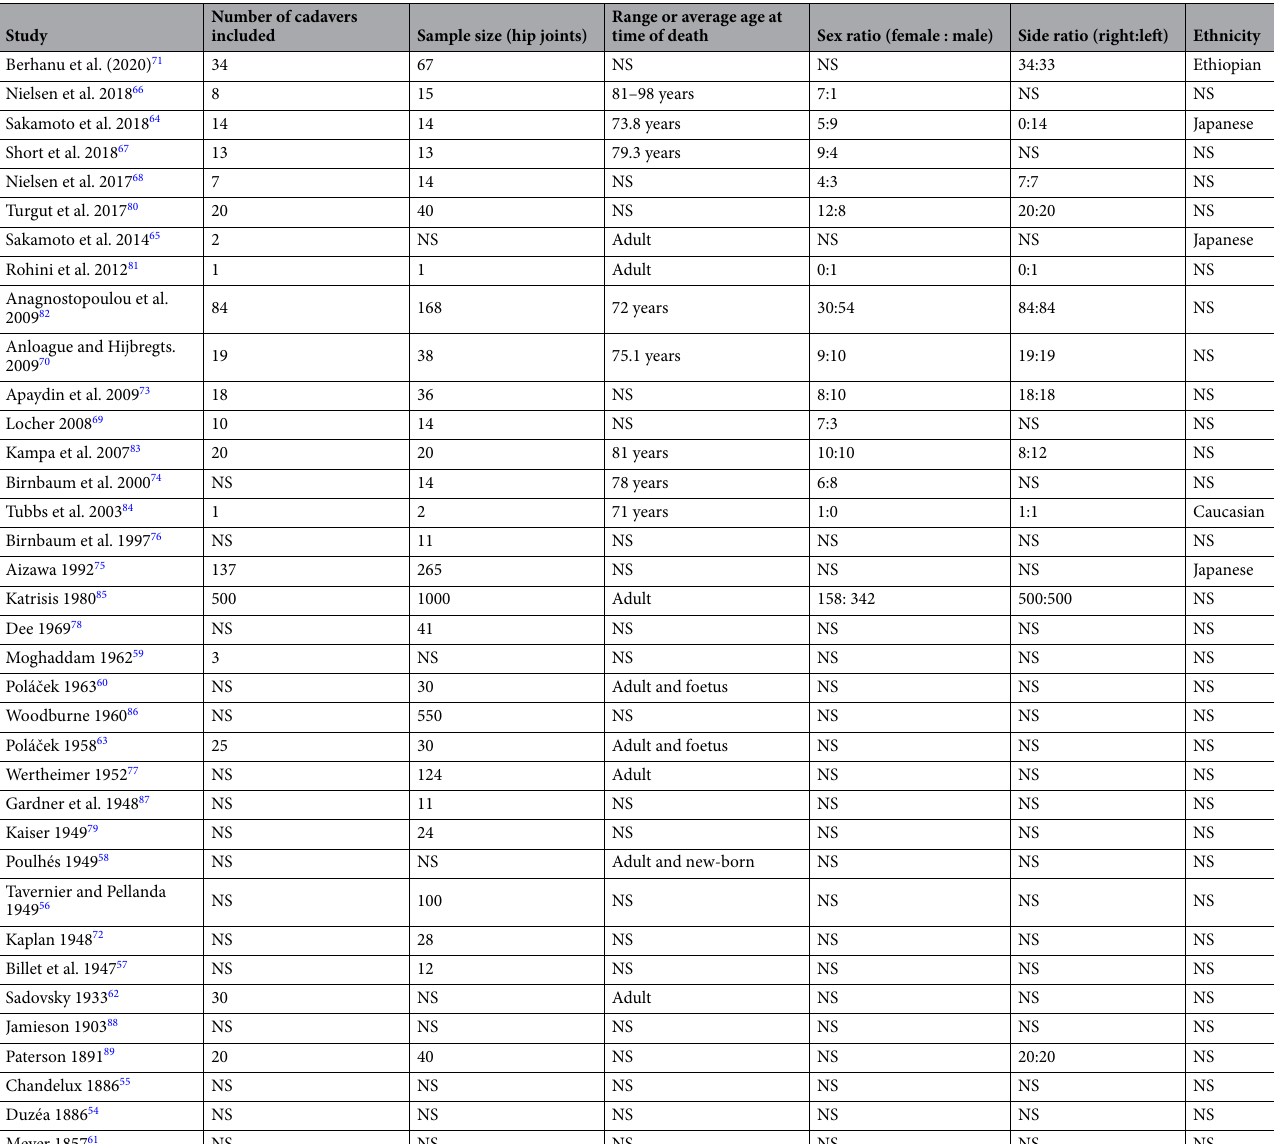
Table 3. Table of study characteristics including sample size and demographic information of cadaveric material studied (age, sex, side, ethnicity), in descending chronological order list. NS = not